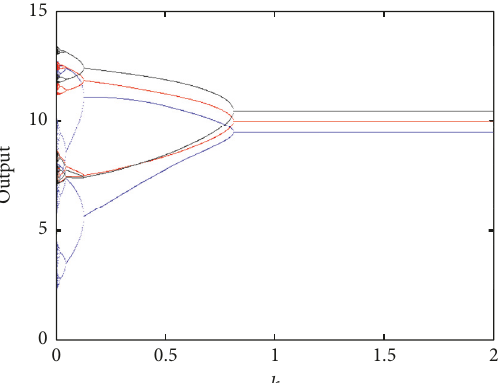
Figure 23: Bifurcation diagram with the controlling factor 𝑘 , 𝛼 = 0.35 , 𝛽 = 0.2 , and 𝛾 = 0.2